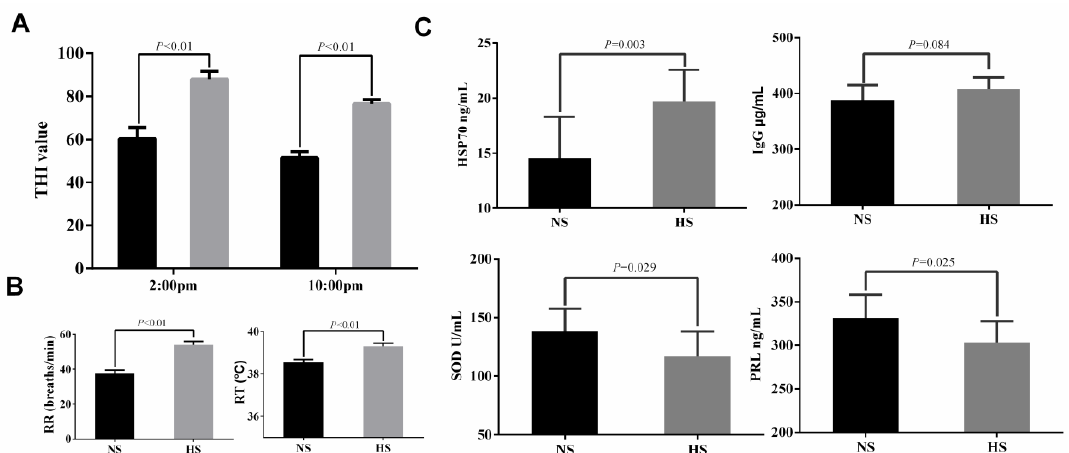
Figure 1. Heat stress-related indicators were identified during the experimental period. ( A ) changes in the temperature-humidity index at di ff erent times; ( B ) respiratory rate and rectal temperature of cows; ( C ) analysis of serum biochemical indices between di ff erent groups. ST, the appropriate temperature group; HS, heat stress group. Black histograms represent NS, and grey histograms represent HS. Table 1. Milk yield and composition in dairy cows.